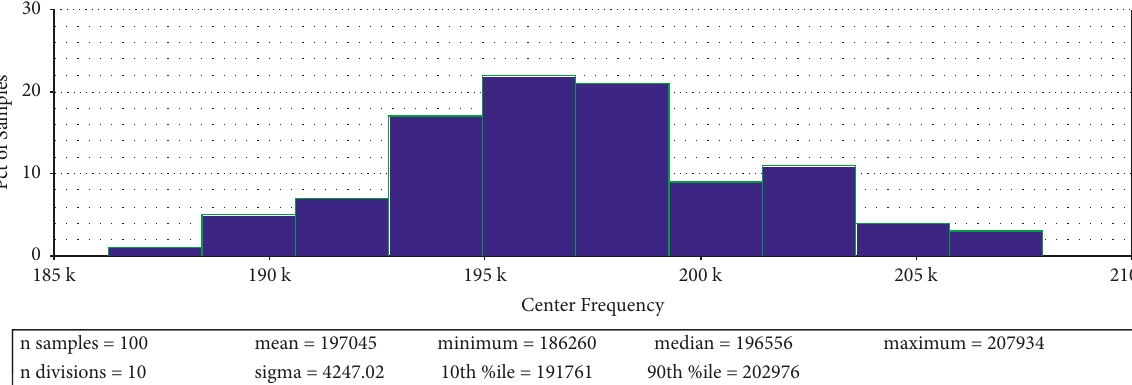
Figure 16: Histogram of Monte Carlo analysis of the band-pass filter with a ± 5% passive element